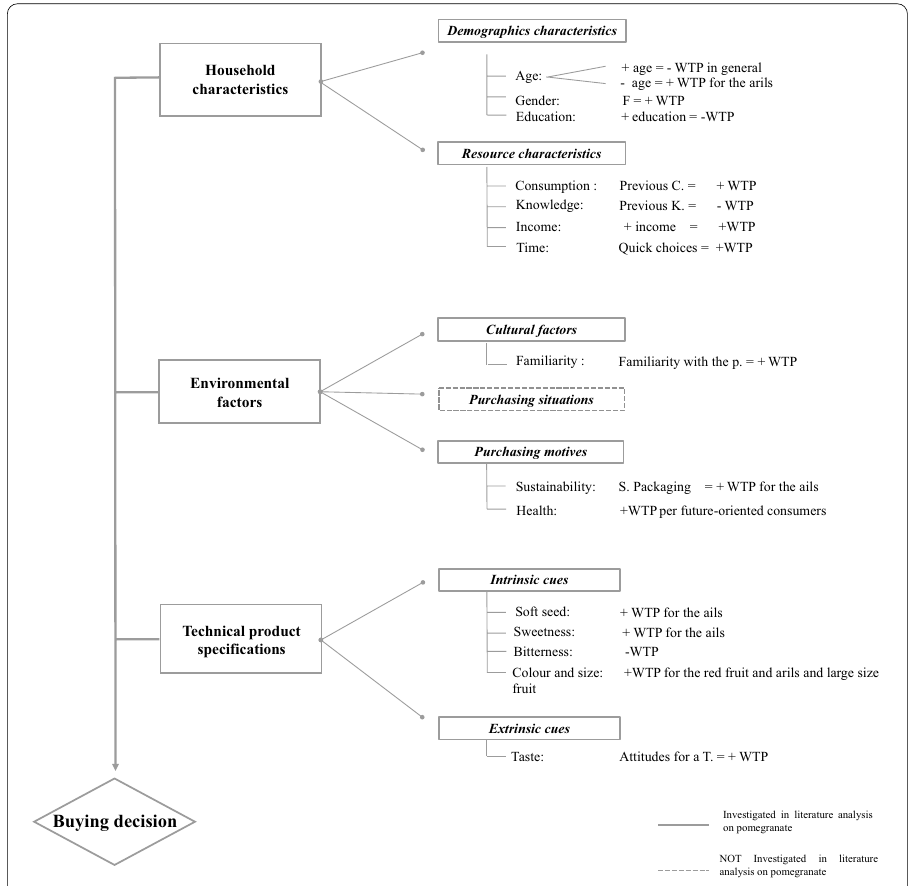
Fig. 8 Buying decision process and impact on consumers’ willingness to pay. Sources: Our elaboration adapted from Grunert et al.